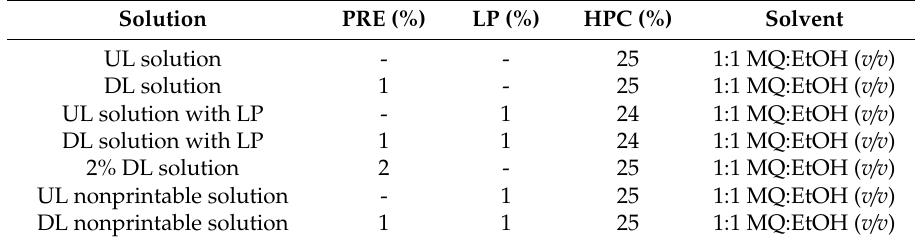
Table 2. Content of the unloaded and drug-loaded printable and nonprintable solutions with and without liver